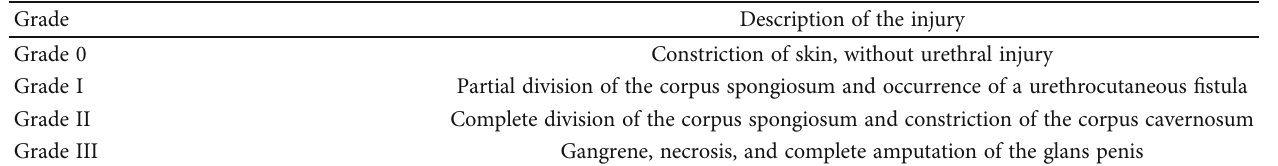
Figure 3: At one month, the wound had completely healed without any complications. Table 1: Classi fi cation of the degree of penile